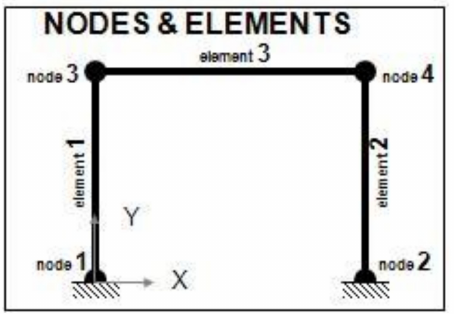
Figure 11. Representation of the OpenSees